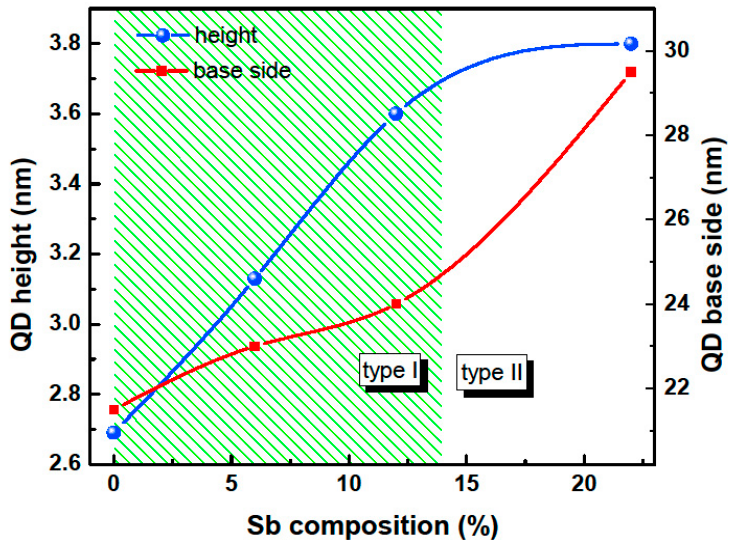
Figure 6. Numerically driven QD height (filled blue circles) and base side (filled red squares) as a function of the Sb content in the CL. The green pattern delimits the low Sb content CL, giving rise to a type I band alignment.